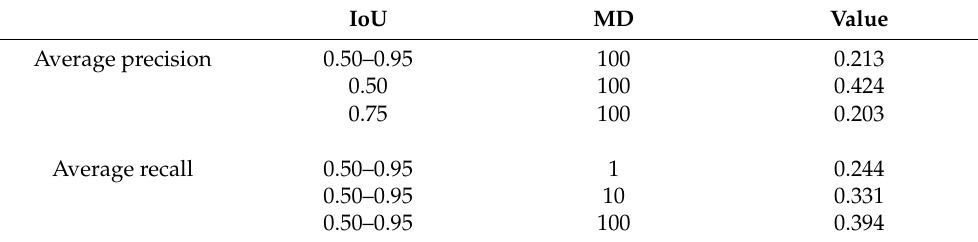
Table A1. Detection performance.